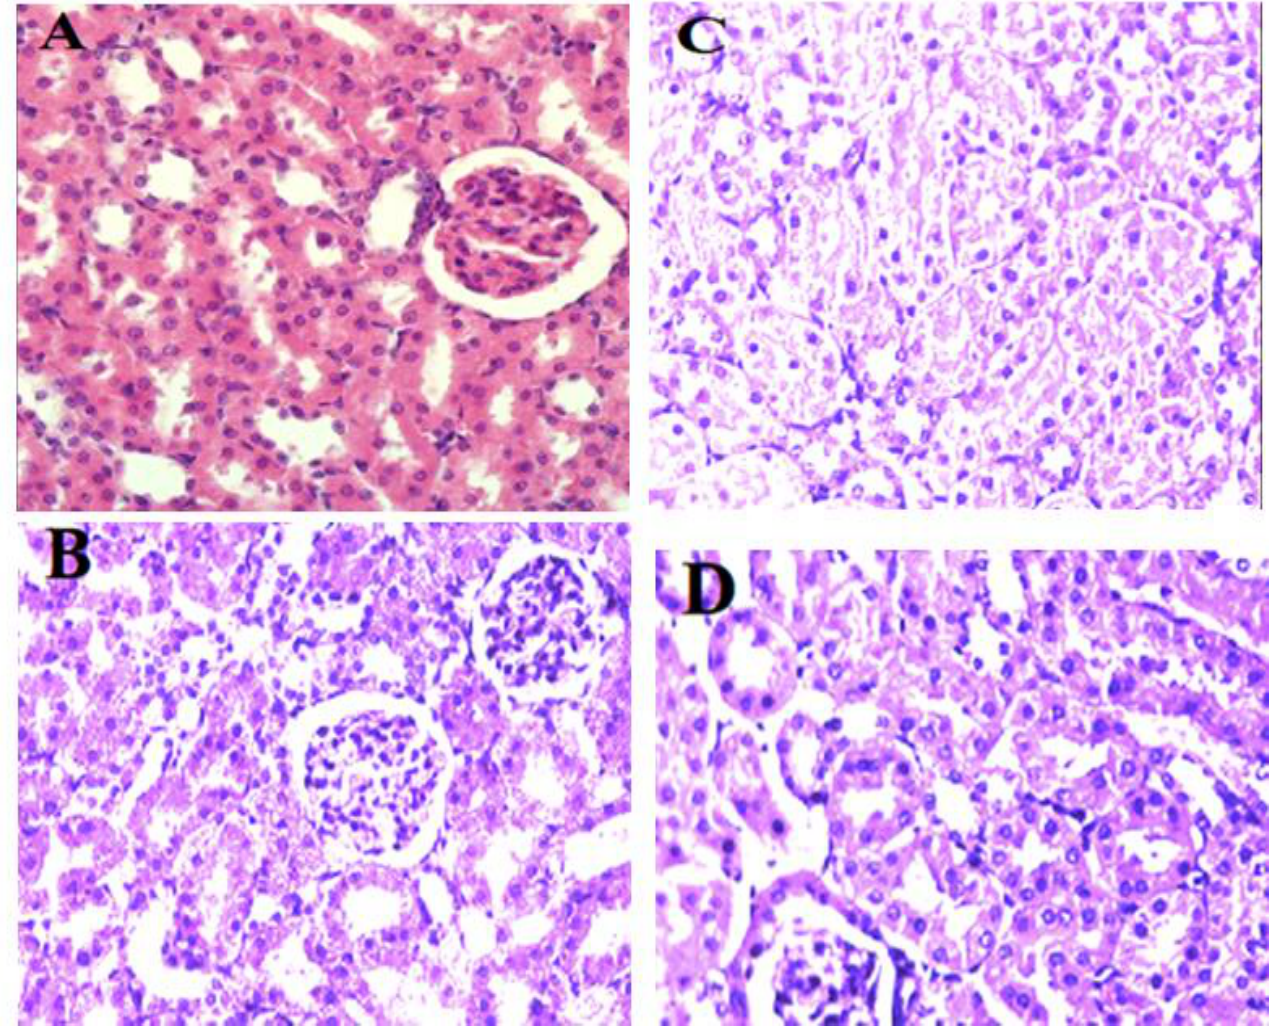
Figure 1. Histopathological findings in kidney. (A) Negative Control group (NC-Gr) and positive control group (E-Gr), reveals normal tissue architecture. (B) Mercuric chloride treated group (Hg-G), nephropathies are characterized by nephrosis, multifocal intracytoplasmic hydropic and tubular degeneration, and a few hyaline casts are present in the distal part of the pars recta between the vascular bundles. (C) HgCl treated group (Hg-G), first part of pars recta showing pyknosis, karyorrhexis, 2 karyolysis and cytoplasmolysis as advanced nuclear and cytoplasmic features of coagulative necrosis together with mild degree of mononuclear cells infiltration. D- Kidney of rat from (HgCl +Vitamin E) 2 treated group (Hg+ E-Gr), a significant reduction in lesions were observed only in the rats that were continuously treated with vitamin E during the course of Hg intoxication, there is pronounced preservation of tubular morphology and frank and significant decreases in the degenerative and nuclear and cytoplasmic necrotic